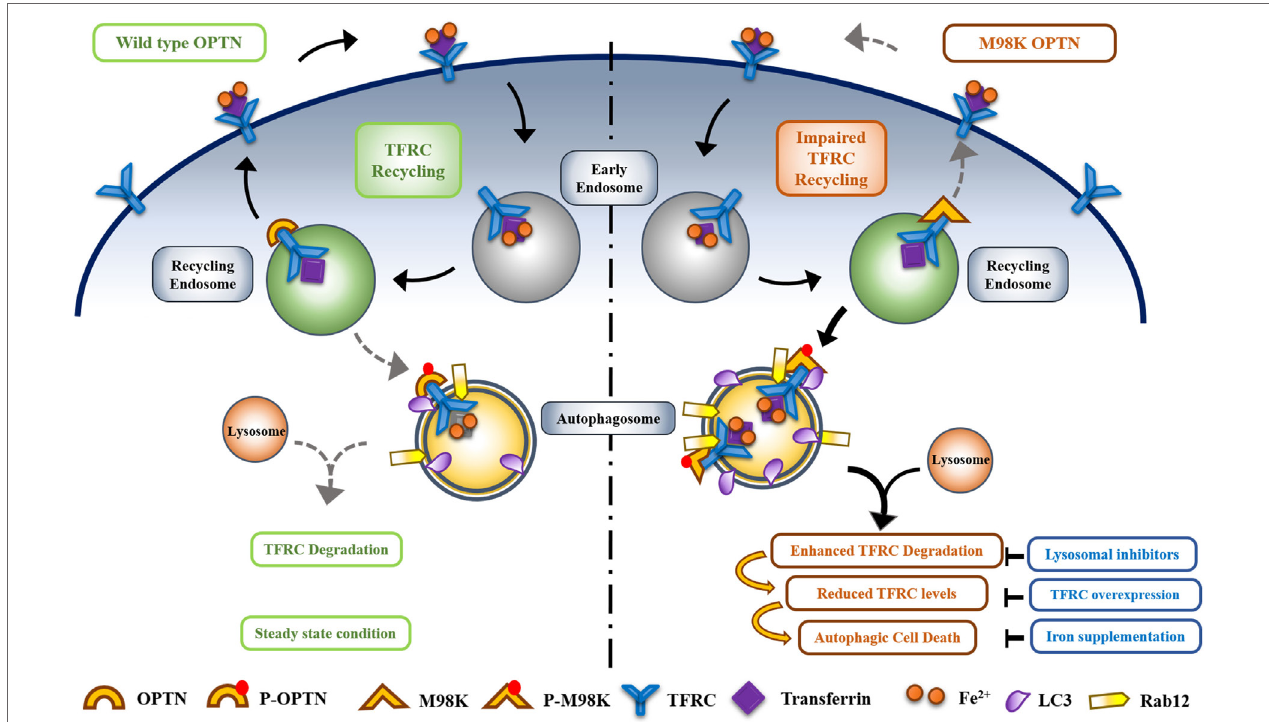
FiGURe 4 | Optineurin (OPTN) acts as a molecular switch that maintains a balance between transferrin receptor (TFRC) recycling and autophagy in retinal cells. M98K mutation in OPTN alters this balance leading to enhanced autophagy that in turn results in reduced recycling of TFRC. Enhanced phosphorylation of M98K-OPTN by TBK1 at S177 plays a crucial role in autophagy-dependent degradation of TFRC leading to cell